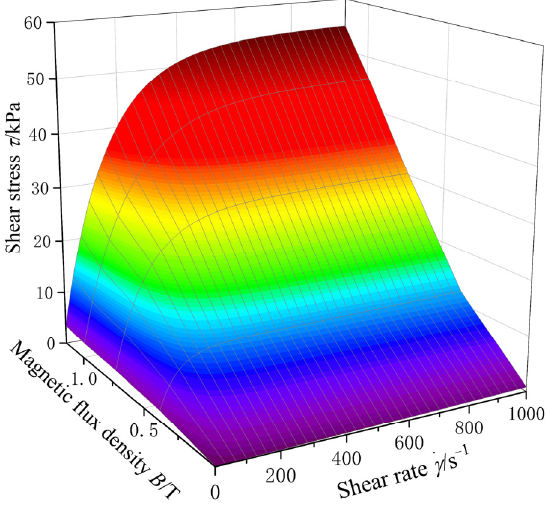
Figure 5. Characteristic surface of the used MR fluid with the type of MRF-J25T.